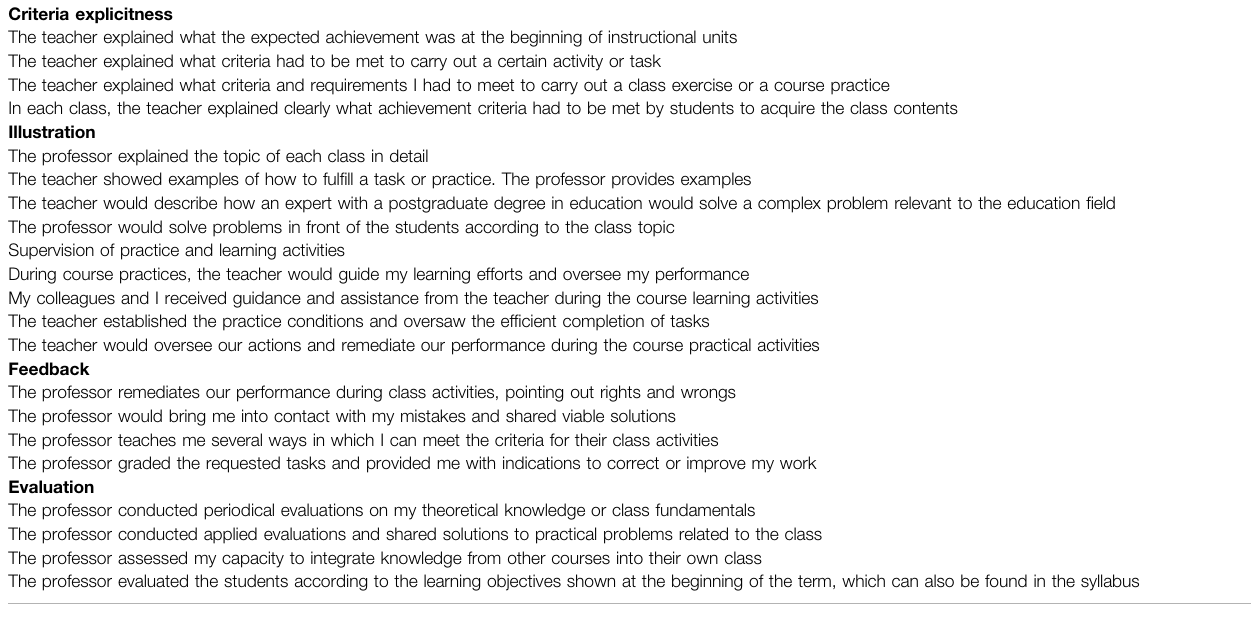
TABLE 2 | Teacher performance criteria: teaching, supervision, and